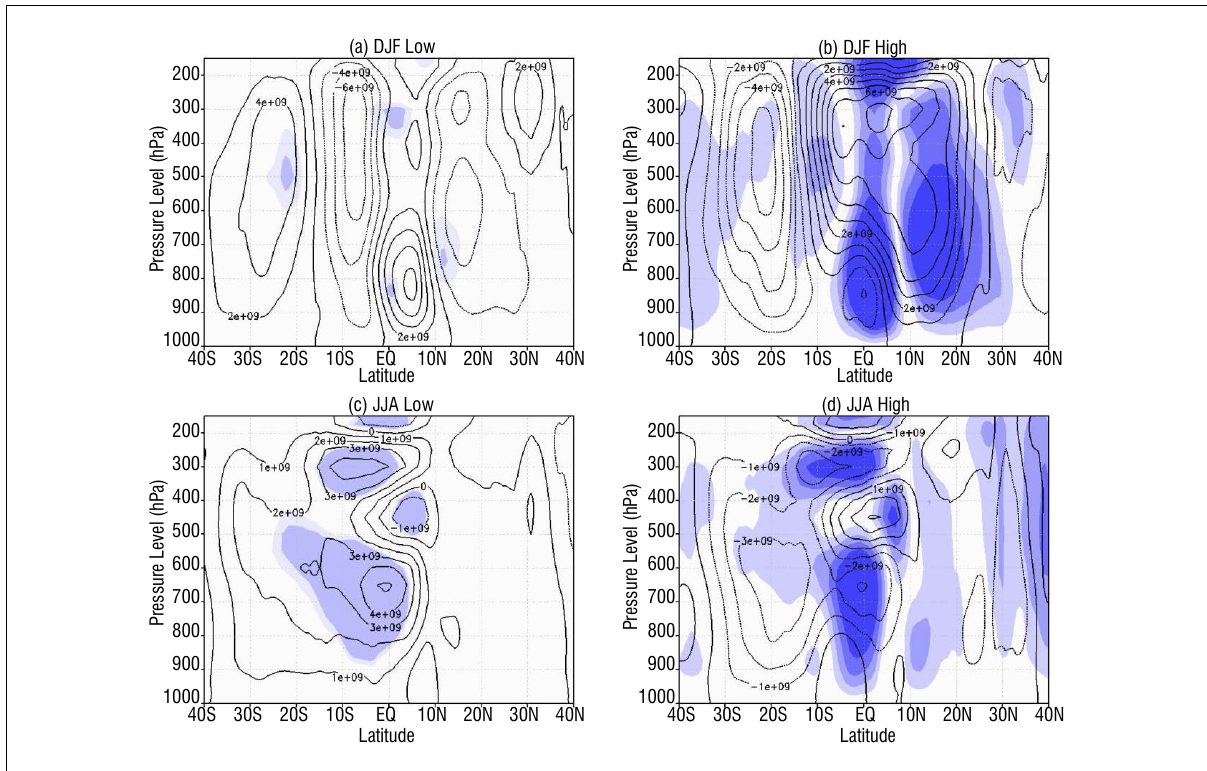
Figure 2: The mass stream function composite anomalies (contour plot) and statistical significance (blue shaded plot) for low cloudiness in (a) December– February (DJF), (c) June–August (JJA) and high cloudiness in (b) DJF and (d)